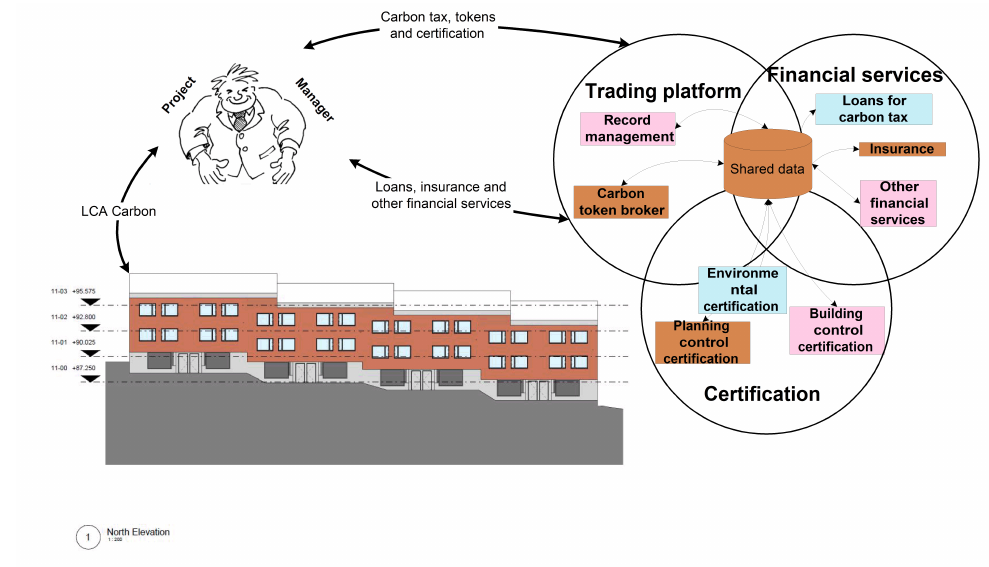
Figure 2. This schematic shows a manager of a building project with access to a CATP (© G . M . C . B lumberg).